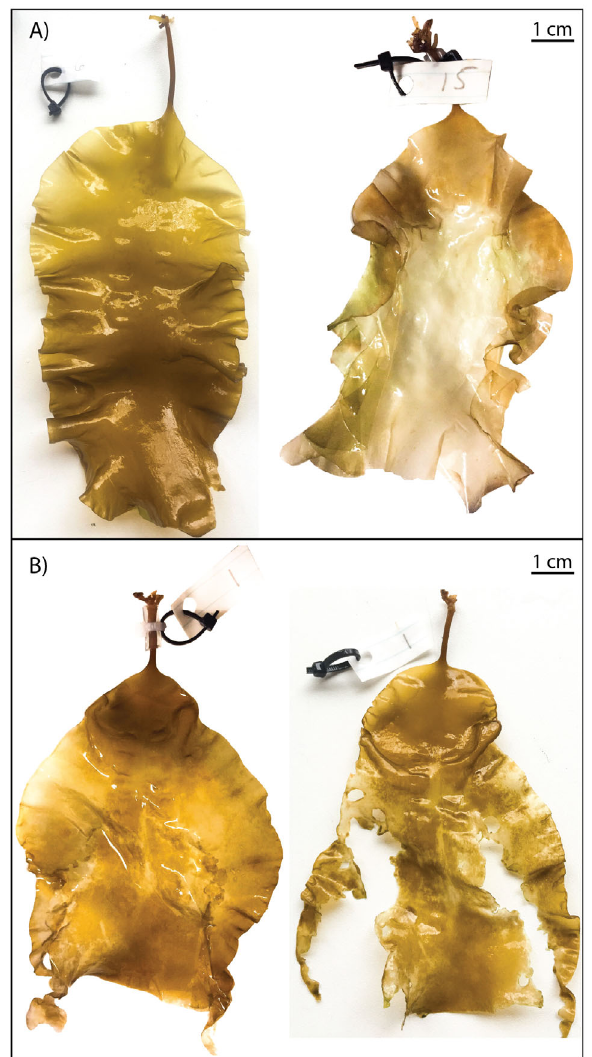
Fig. 2. Effects of different concentrations of H 2 O 2 on lamina of juvenile Saccharina latissima plants at different time in- tervals. (A) Normal lamina with no visible damages 15 d post-exposure to concentrations ≤ 17 mg l −1 (left), and dis- coloured and pale lamina 3 d post-exposure to 170 mg l −1 (right); (B) discoloured lamina due to pigment loss 8 d post- exposure to 85 mg l −1 (left), and lamina with loss of tissue due to cell death 15 d post-exposure to 85 mg l −1